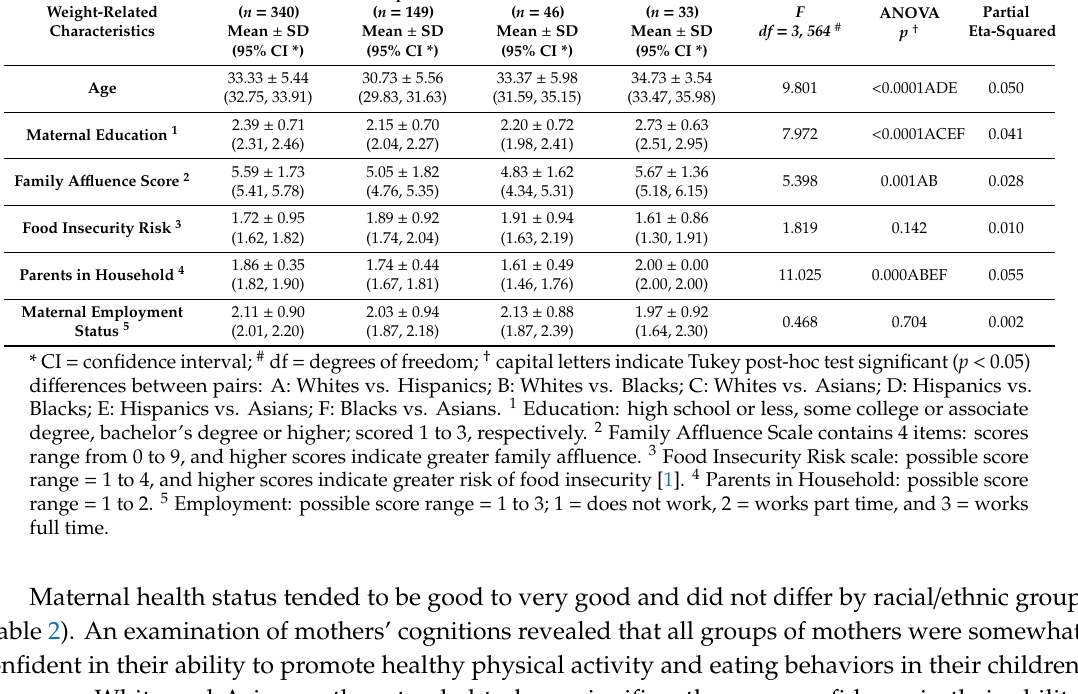
Table 1. Demographic Characteristics by Maternal Race / Ethnicity ( N = 568). Weight-Related Characteristics